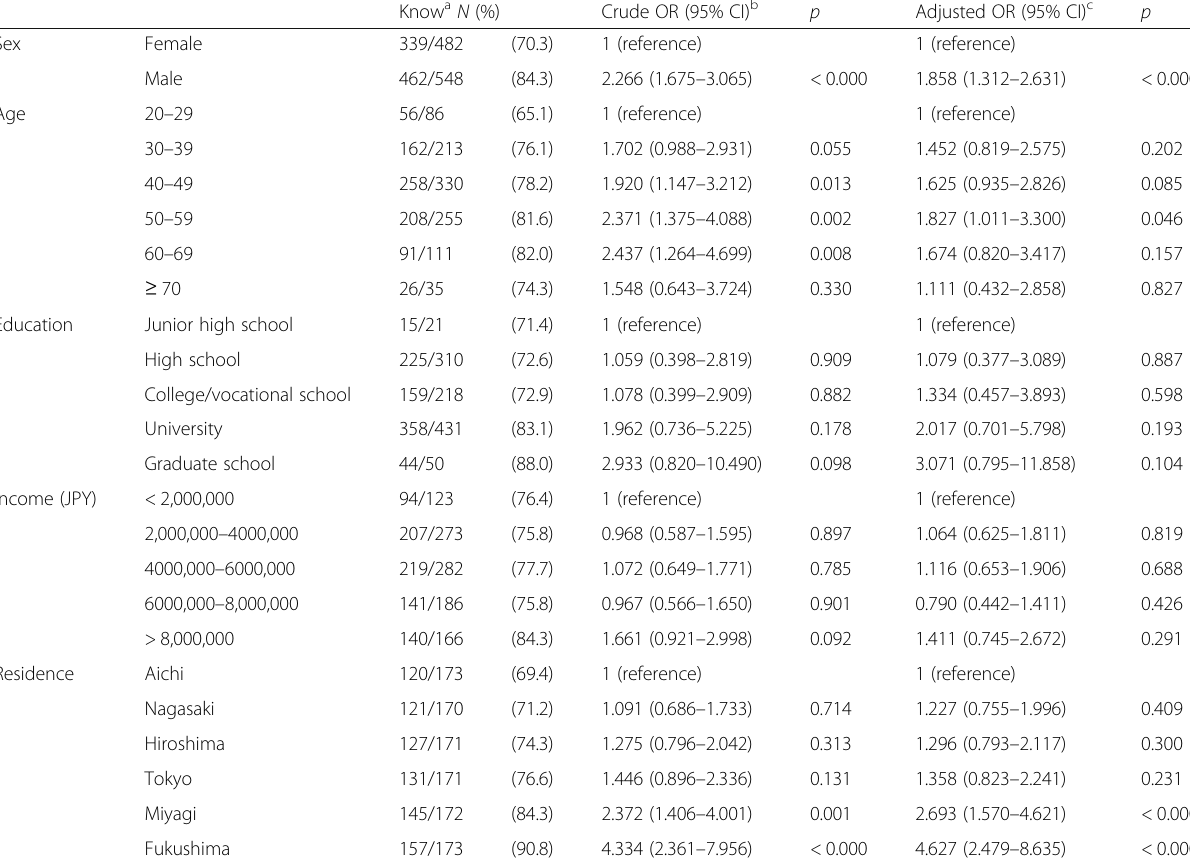
Table 3 Odds ratios (OR) and 95% confidence intervals (CI) for awareness of the recognition level of the 20 technical terms regarding